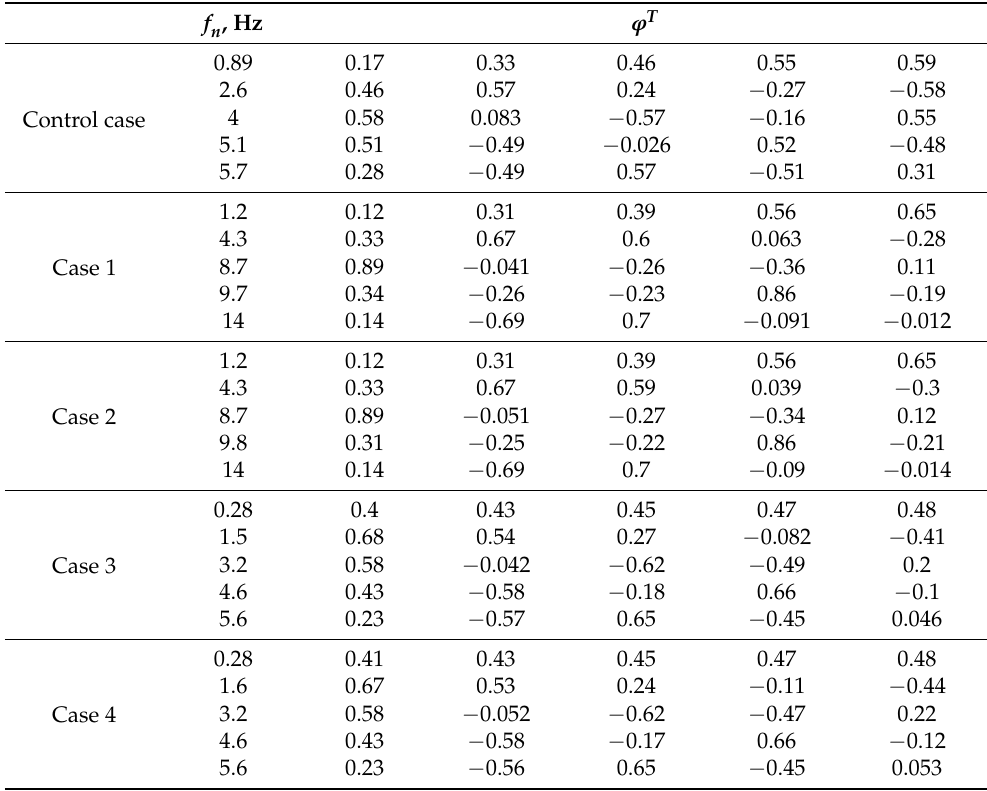
Table 7. Natural frequencies and mode shapes for each case. f , Hz ϕ T n